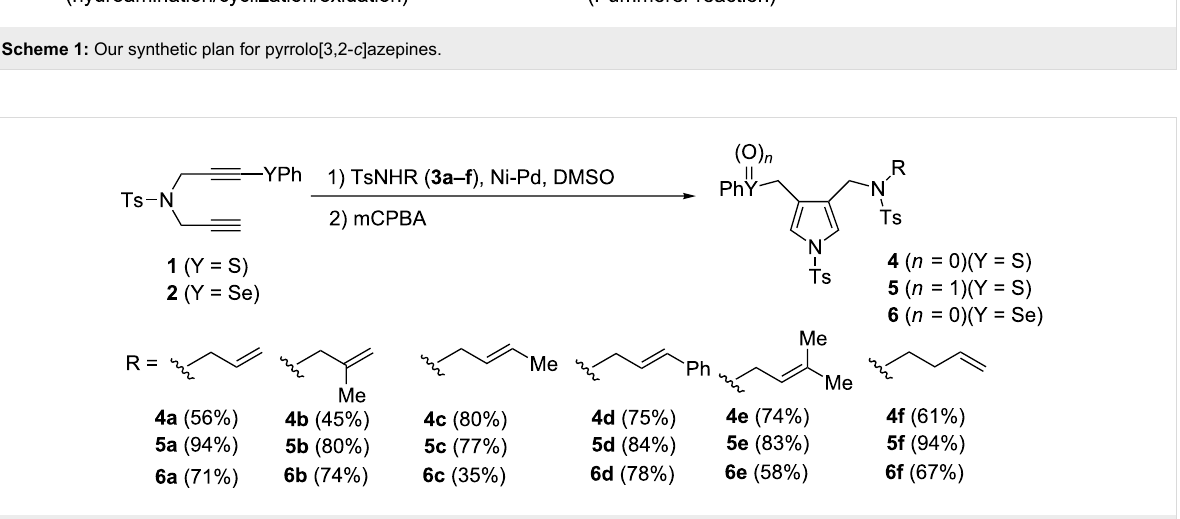
Scheme 2: Preparation of precursors for the Pummerer